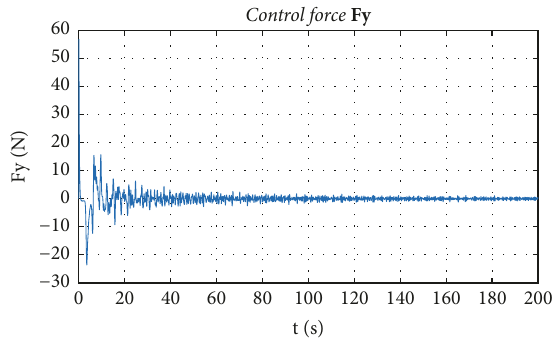
Figure 11: Control force 𝐹 𝑦 with vibration control.